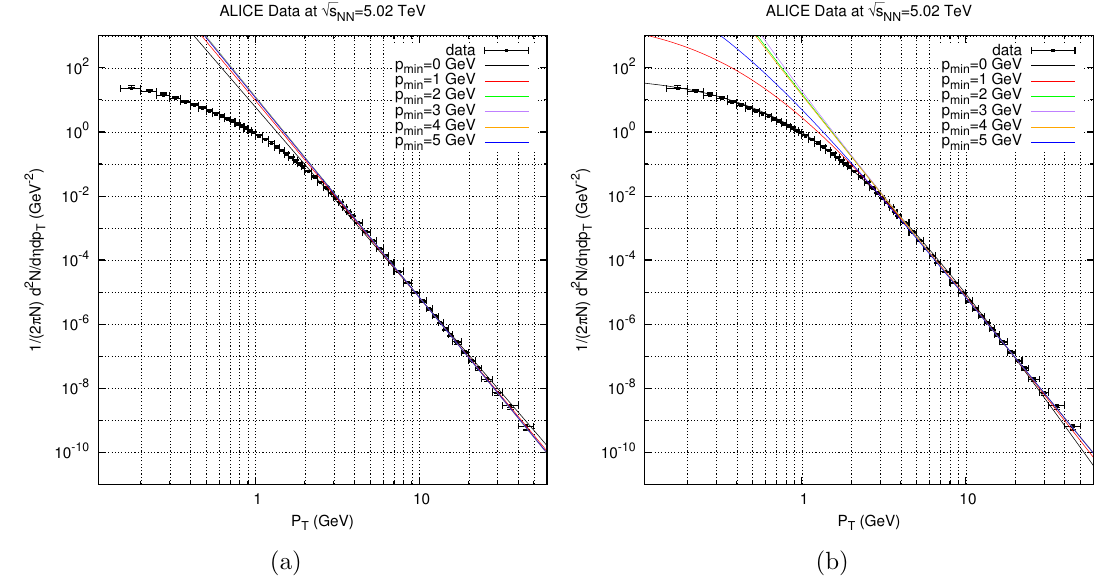
Figure 14. Fit of the two parameter ansatz in eq. (E.2) (left) and the three parameter ansatz in eq. (E.3) to the ALICE dataset at p s = 5 : 02 TeV in the data cuto(cid:11)s.